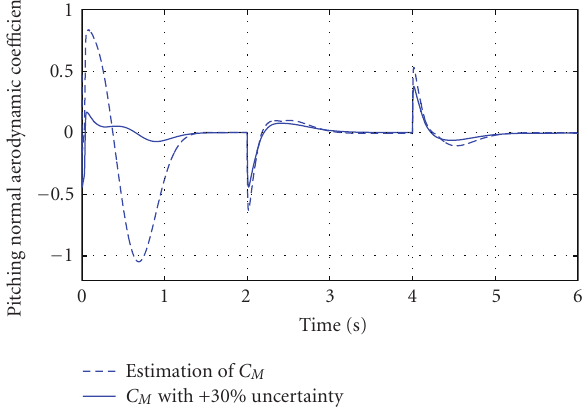
Figure 16: Pitching moment aerodynamic coe ffi cient estimation with adaptive sliding